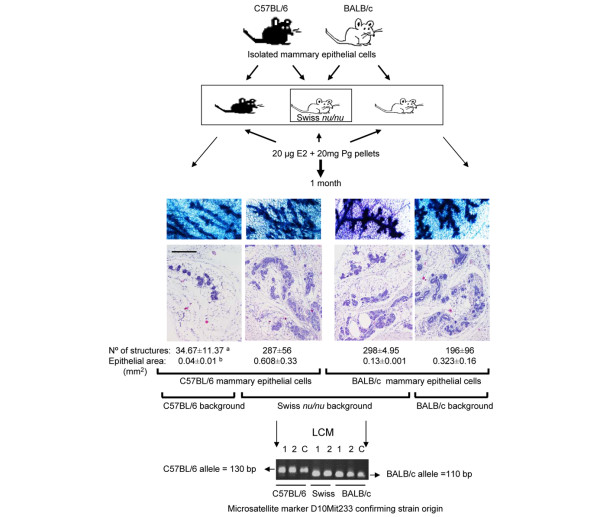
Morphology of reconstituted mammary glands of both strains into a nude background. Mammary cells were isolated from 2-month-old BALB/c or C57BL/6 mice and 5 μl of cell suspensions were transplanted into the right or left cleared mammary fat pads, respectively, of 21-day-old Swiss nu/nu or syngeneic mice. At surgery pellets containing E2 plus Pg or plus MPA were also implanted subcutneously into the backs of the animals. One month later, animals were killed and mammary glands excised and fixed. Microscopic examination revealed no changes between C57BL/6 or BALB/c repopulated Swiss nu/nu glands, whereas C57BL/6 cells transplanted in syngeneic glands were under-developed (100×, bar: 700 μm). A representative image of the WM or the H&E stained slides of the reconstituted mammary glands in E2/Pg-treated mice is shown. Microsatellite studies confirmed the strain origin of the epithelial cells in the Swiss background. bp, base pairs; E2, 17β-estradiol; H&E, hematoxylin and eosin; LCM, laser capture microdissection; MPA, medroxyprogesterone acetate; Pg, progesterone; WM, whole mount.